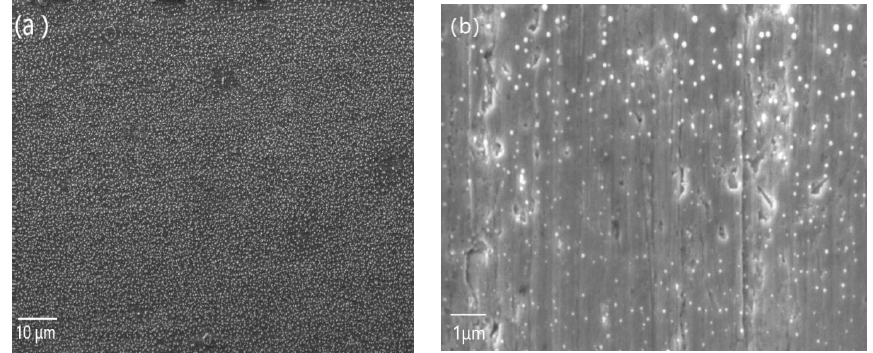
Figure 4. The Scanning electron microscopy (SEM) images of nano-silver after in magnification of 1000× ( a ) and 8000× ( b ).